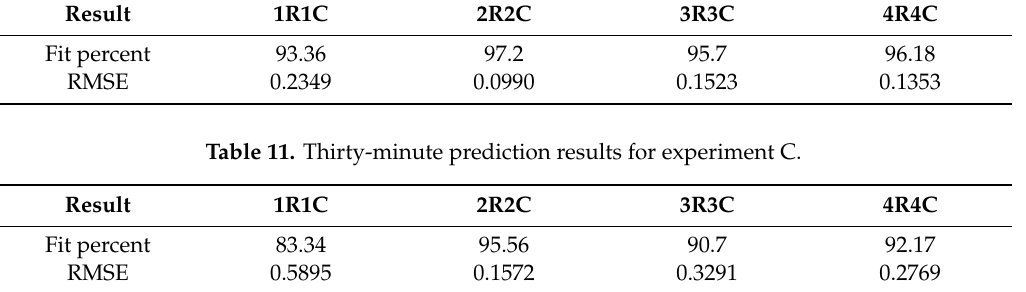
Figure 6. Residual autocorrelation — Experiment B — order 3.